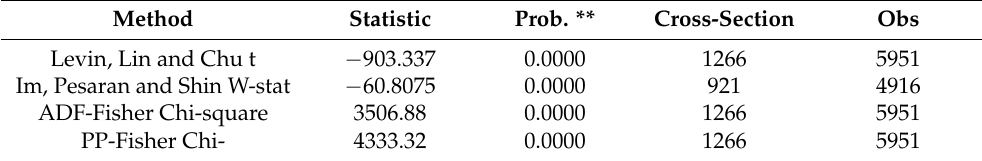
Table A2. Panel unit root test results.